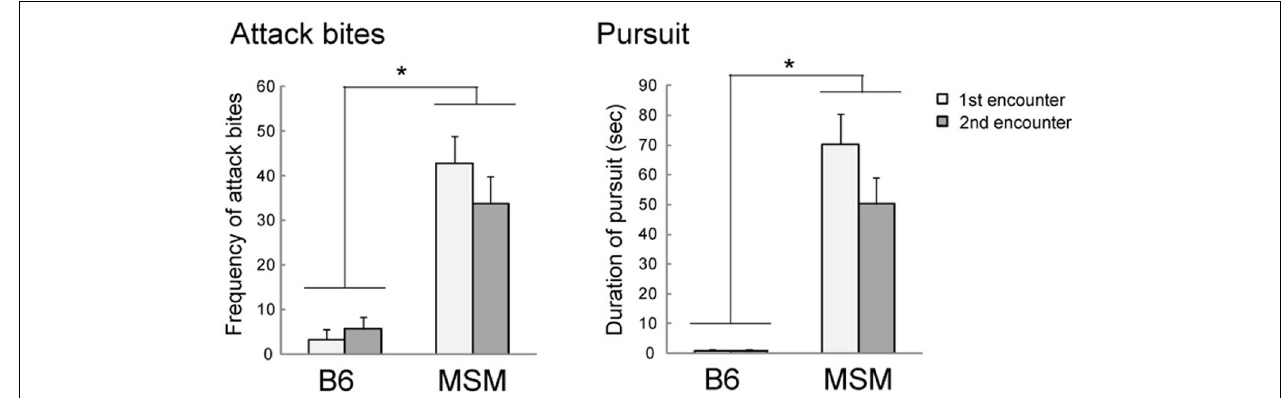
FIGURE 1 | Aggressive behaviors of MSM and B6 in the resident-intruder test. MSM showed significantly more attack bites and pursuit than B6 at both first and second encounters. ∗ Significant strain difference between B6 and MSM ( p < 0 .